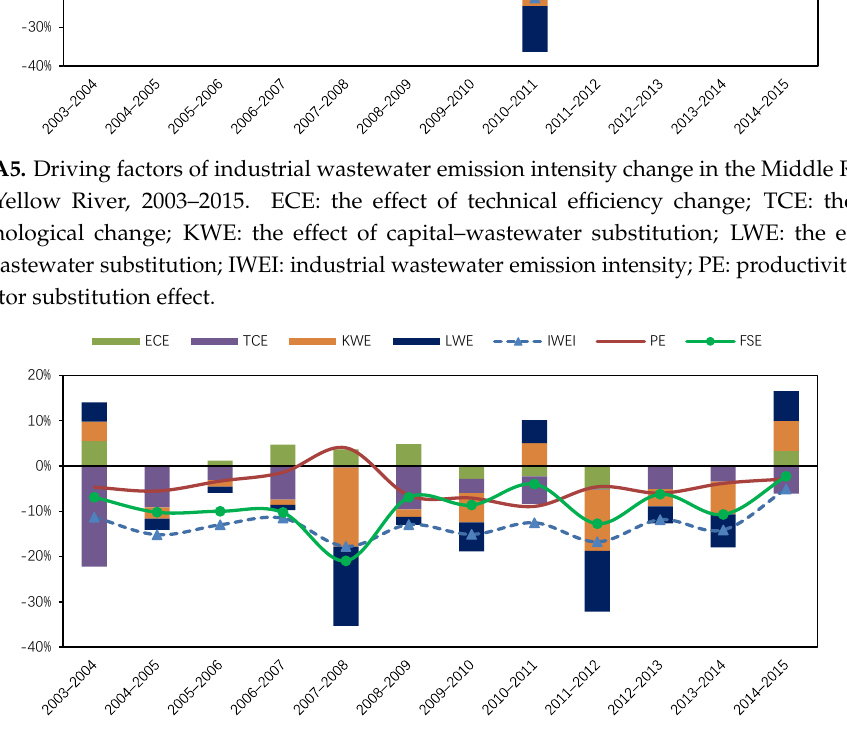
Figure A6. Driving factors of industrial wastewater emission intensity change in the Middle Reaches of the Yangtze River, 2003 – 2015. ECE: the effect of technical efficiency change; TCE: the effect of technological change; KWE: the effect of capital – wastewater substitution; LWE: the effect of labor – wastewater substitution; IWEI: industrial wastewater emission intensity; PE: productivity effect; FSE: factor substitution effect.